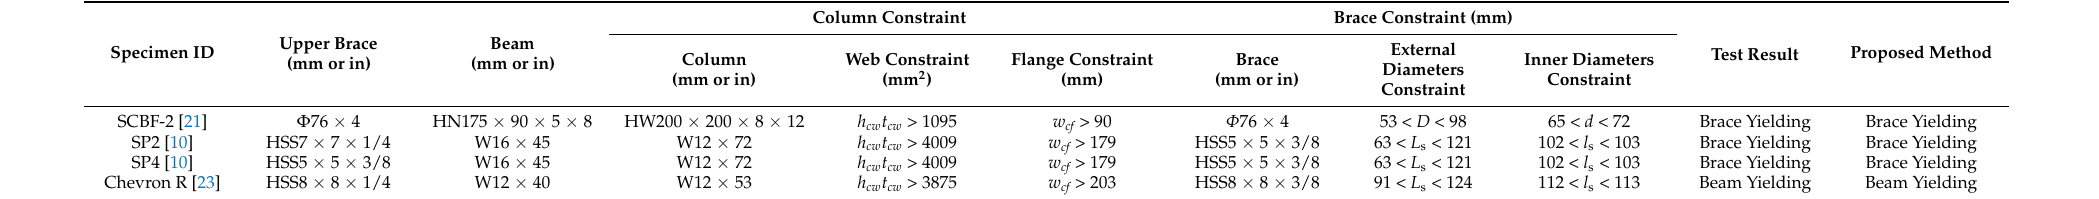
Table 3. Experimental verification results (typical